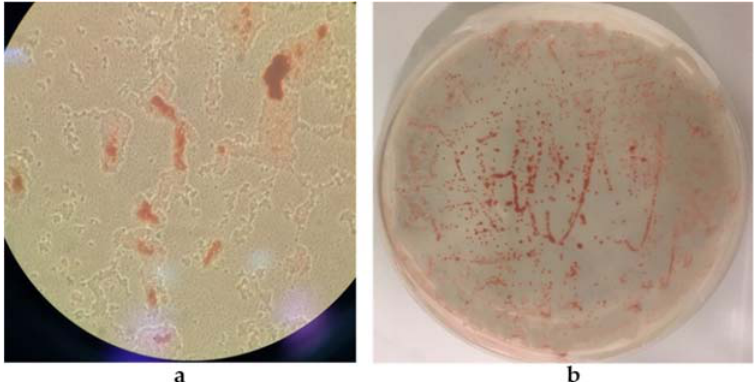
Figure 9. The 5AG strain’s cellular localization of selenite reduction products in medium B. Panel ( a ) optical microscopy (magnification 40×) of cells incubated in liquid medium; Panel ( b ) cells incubated in solid medium.